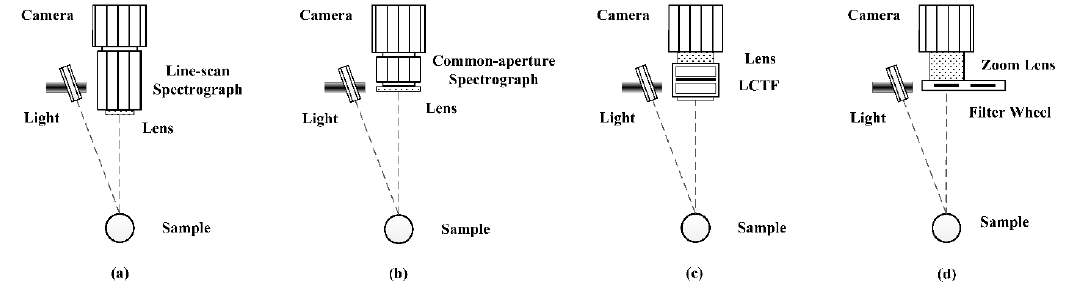
Figure 6. Four sensing configurations for scattering measurement: ( a ) line-scan spectrograph based, ( b ) common-aperture spectrograph based, ( c ) liquid-crystal tunable filter (LCTF) based and ( d ) filter wheel based.